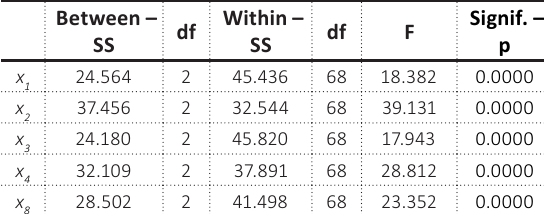
Table 3. Dispersion analysis of Ukrainian bank clusters by their reliability levels (after excluding certain financial parameters that are not significant for clustering)